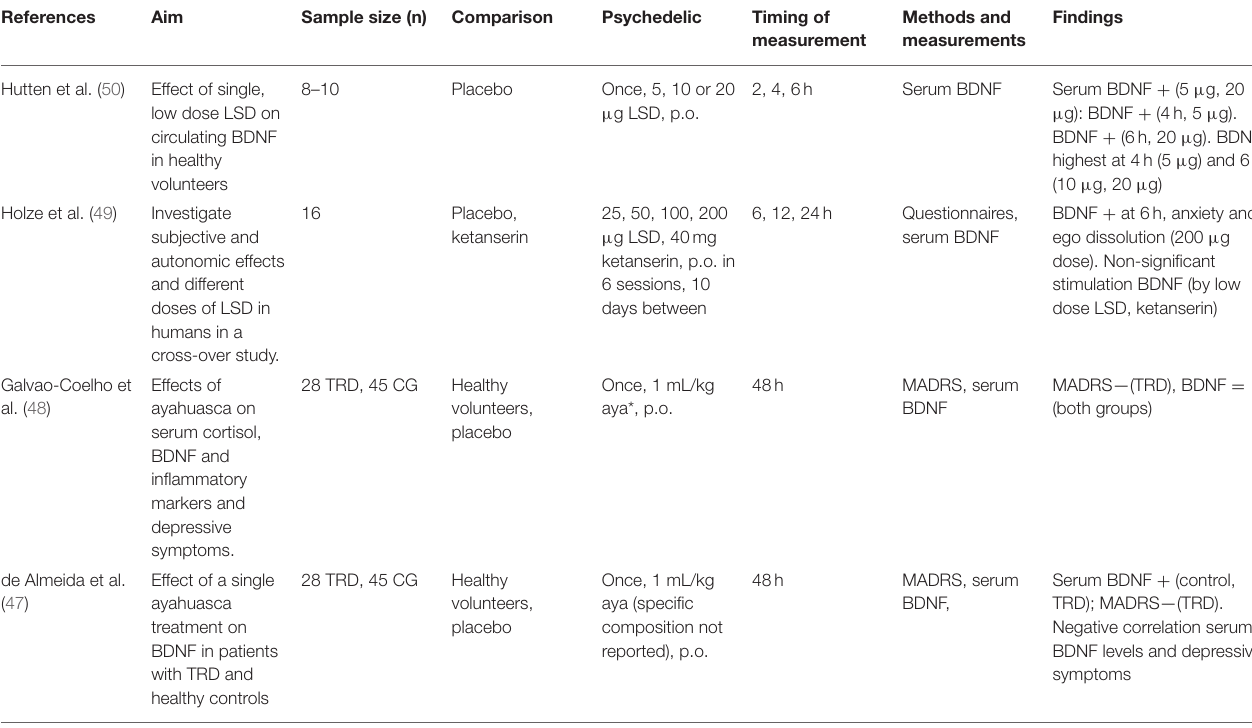
TABLE 2 | Clinical studies investigating cellular and molecular effects of serotonergic